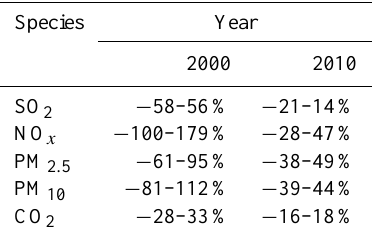
Table 6. Uncertainty ranges of emission estimates for a large coal- fired generation unit (600MW, pulverized boiler, equipped with FGD, LNB, and an electrostatic precipitator) in China; the values represent the 95% CI around the